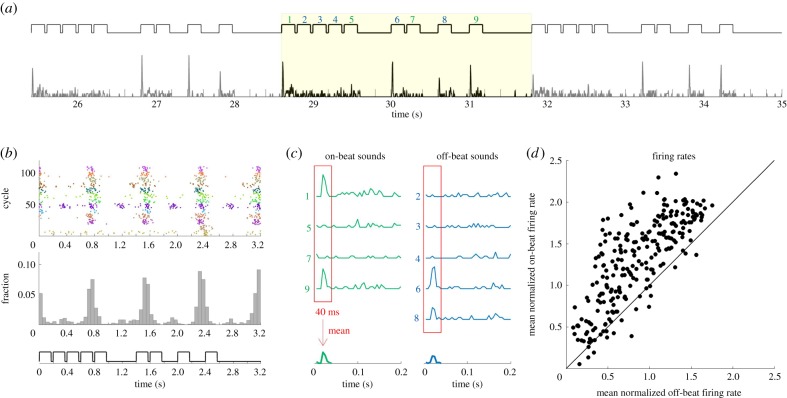
On-beat responses are on average stronger than off-beat responses. (a) An example unit's normalized peri-stimulus time histogram (PSTH) to stimulus pattern P2 at 1 × tempo. The last three complete cycles of this pattern are shown together with the stimulus trace above. The coloured numbers indicate noise bursts, green being on-beat and blue being off-beat. Normalization was done by dividing each unit's firing rate concatenated across all seven stimuli by its standard deviation. (b) Raster-style plot showing tap times of human listeners across trials and cycles of this stimulus. Each dot marks the timing of a tap, each row of dots shows tap responses for a single cycle of the stimulus pattern and different colour dots distinguish the tap responses from different subjects. Beneath is a histogram of tap times pooled across subjects, cycles and trials for this stimulus. A clear, regular tapping pattern is present, which indicates a strong consensus among listeners to hear four beats in this 16-event sequence, timed on the 1st, 5th, 9th and 13th interval. (c) Normalized firing rate in response to on-beat (left, in green) and off-beat (right, in blue) noise bursts for the highlighted cycle shown in panel a. To quantify a unit's mean on- and off-beat response, the firing rate over the first 40 ms of each sound-evoked response to on-beat and off-beat sounds (red boxes) across all 33 s of all stimuli was averaged (the averages based on just the highlighted cycles are shown for demonstration purposes), and the mean of the result was taken. (d) Scatter plot showing the mean on-beat response for each unit as a function of that unit's mean off-beat response. Most points fall well above the main diagonal, indicating that, on average, on-beat sounds evoked stronger responses than off-beat sounds.